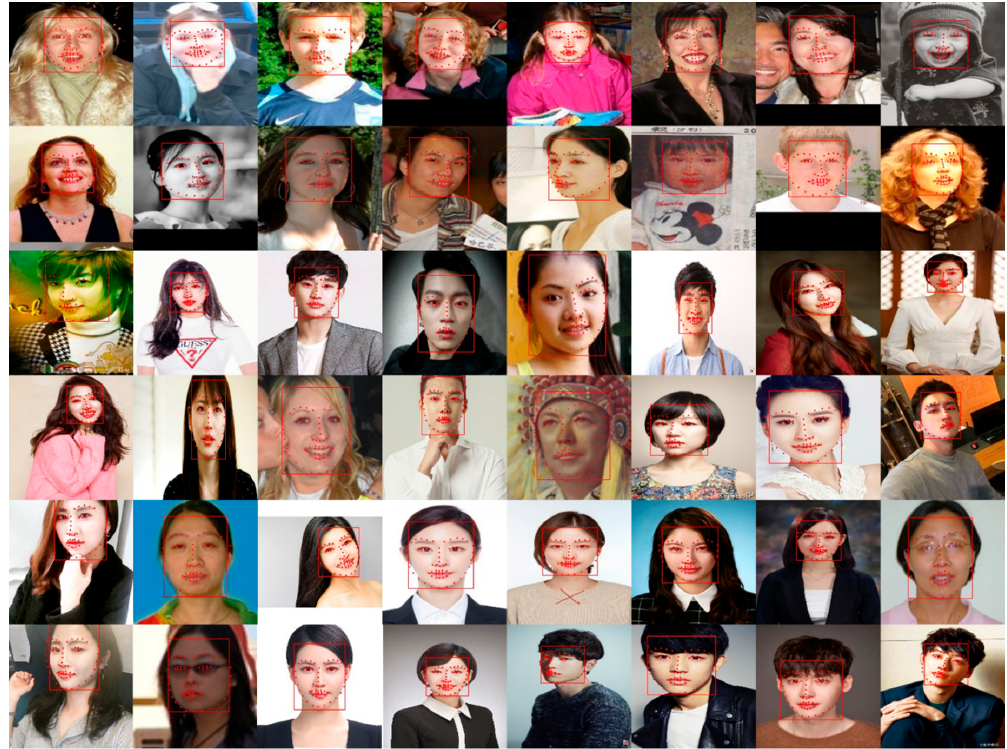
Figure 9. Facial landmark points extracted by our Augmented EMTCNN model. Figure 8. Facial landmark points extracted by our Augmented EMTCNN